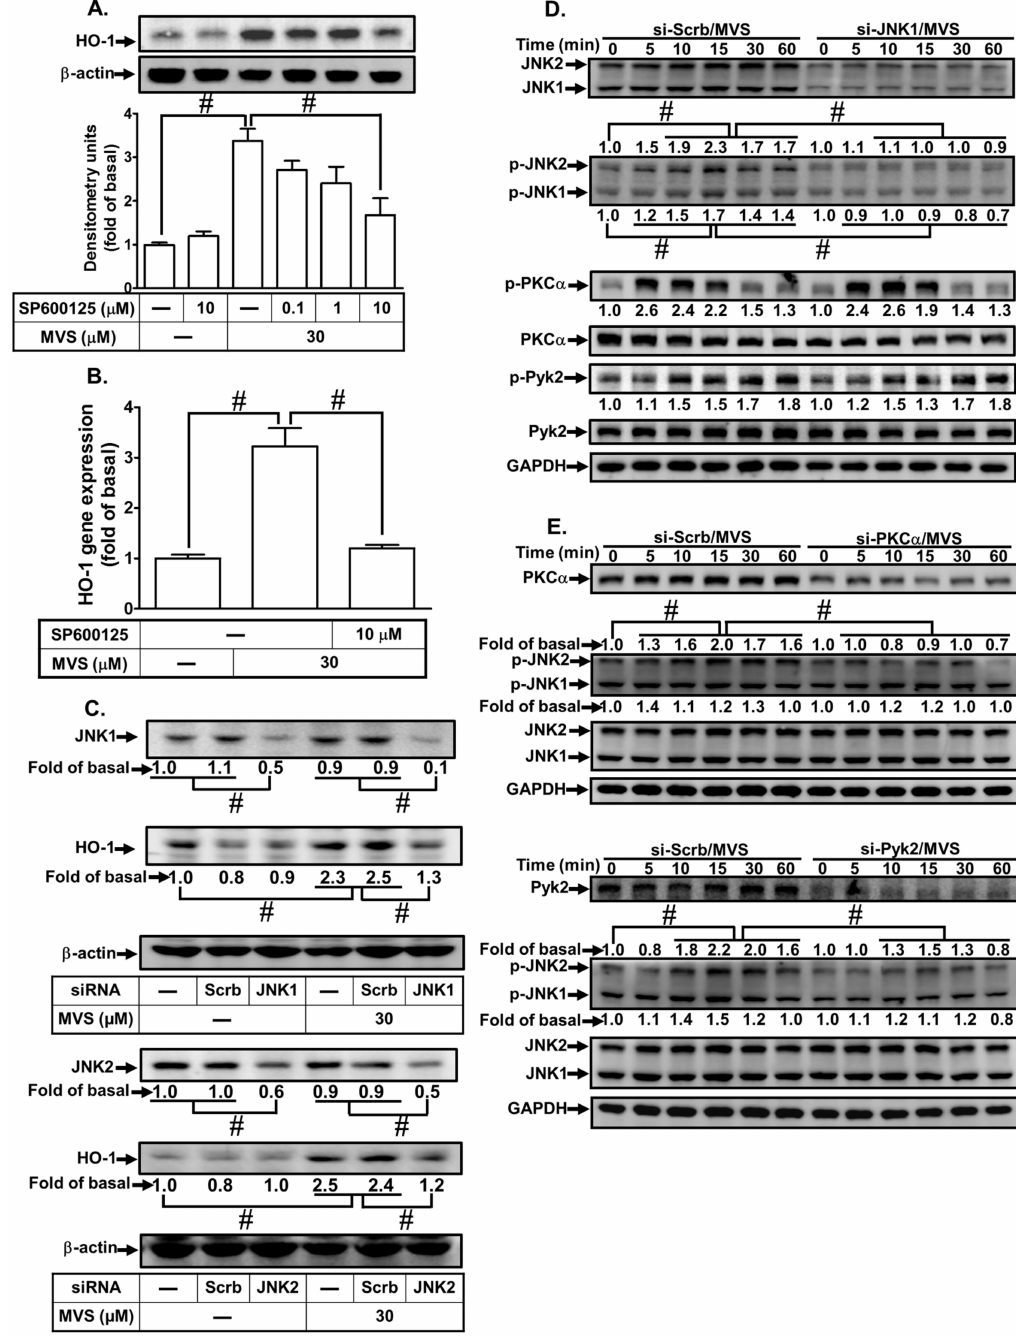
Figure 5. Activation of JNK1 / 2 contributes to the MVS-induced HO-1 expression. ( A ) HPAEpiCs were pretreated with various concentrations of SP600125 for 1 h and then incubated with MVS for 24 h. The protein levels of HO-1 and β -actin were determined by Western blot. ( B ) Cells were pretreated with SP600125 (10 µ M) for 1 h and then incubated with MVS for 8 h. The levels of HO-1 mRNA were determined by real-time qPCR. ( C ) Cells were transfected with scrambled (Scrb), JNK1, or JNK2 siRNA and then incubated with MVS for 24 h. The levels of JNK1, JNK1, HO-1, and β -actin protein expression were determined by Western blot. ( D , E ) HPAEpiCs were transfected with scrambled (Scrb), PKC α , Pyk2, or JNK1 / 2 siRNA and then incubated with MVS for the indicated time intervals. The levels of phospho-JNK1 / 2, JNK1 / 2, phospho-PKC α , PKC α , phospho-Pyk2, Pyk2, or GAPDH were determined by Western blot. Data are expressed as mean ± SEM of five independent experiments ( n = 5). # p < 0.01, as compared with the cells exposed to the indicated